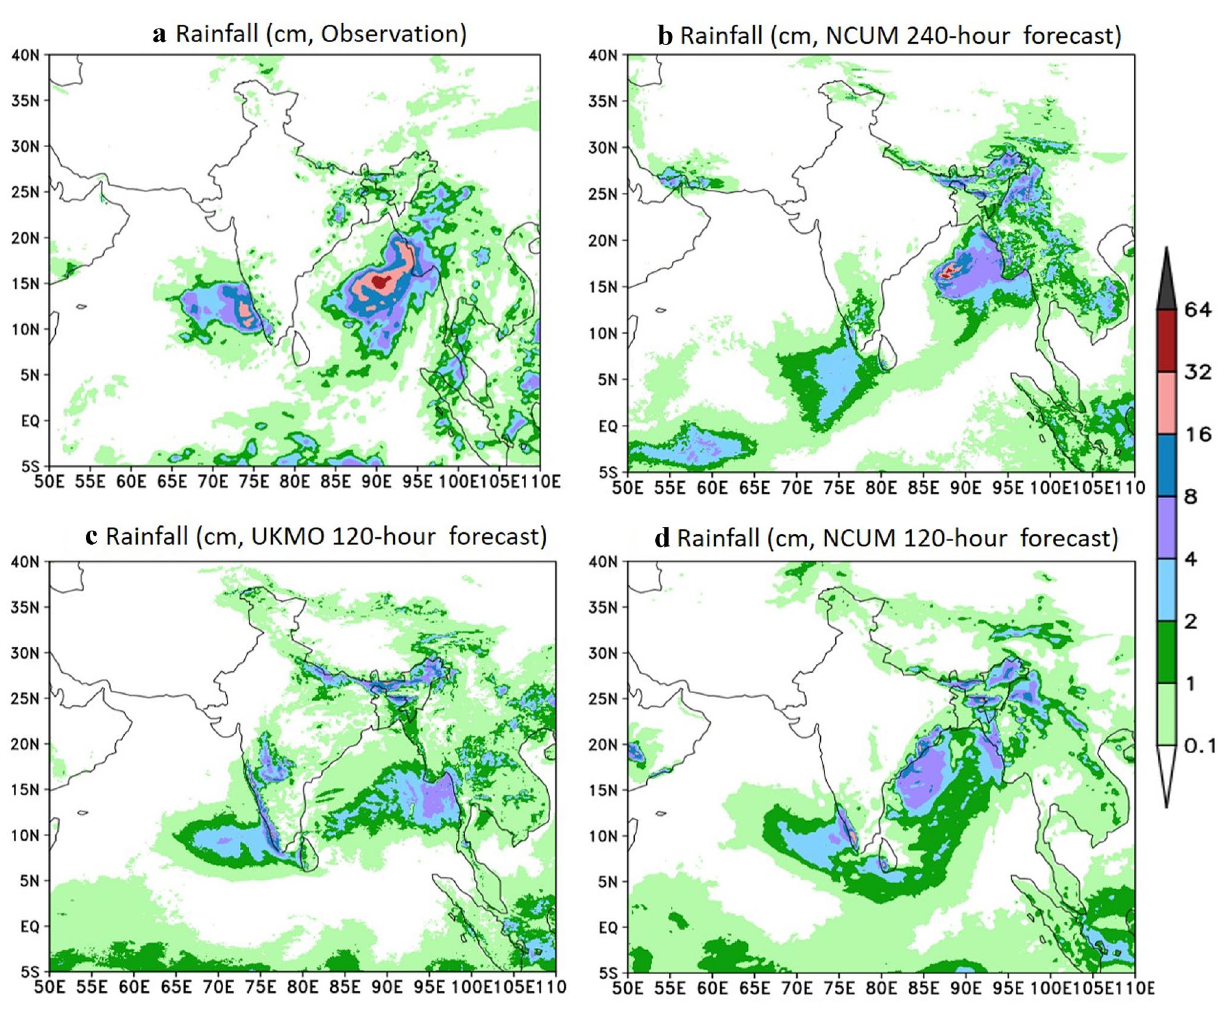
Fig. 8 The spatial distribution of rainfall (cm) of a observation, b NCUM 10-day forecast, c UKMO 5-day forecast, and d NCUM 5-day forecast valid at 00Z 29 May